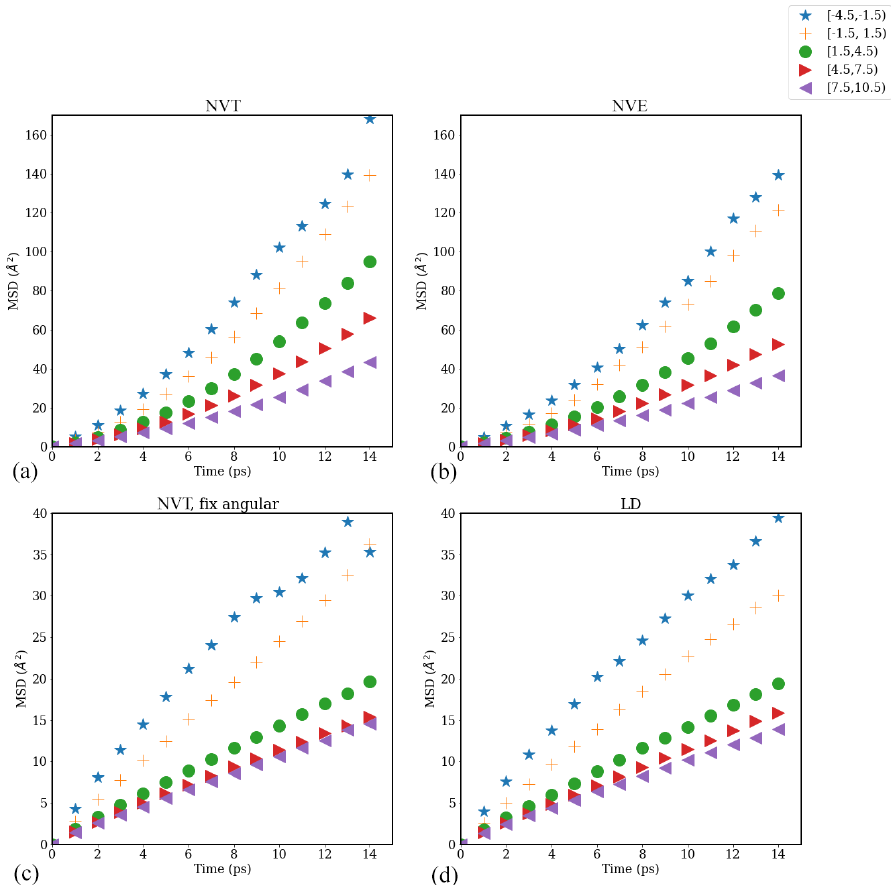
Figure A6. Mean square displacement (MSD) of water molecules as a function of time evaluated in different interfacial layers in the direction parallel to the time-averaged Gibbs dividing surface in simulations carried out with different thermostats: (a) NVT, (b) NVE (number of particles–volume–energy), (c) NVT with fixed angular momentum, and (d) Langevin dynamics (LD) with a friction constant of γ = 0 . 5ps − 1 for a pure-water droplet with N w = 1000.